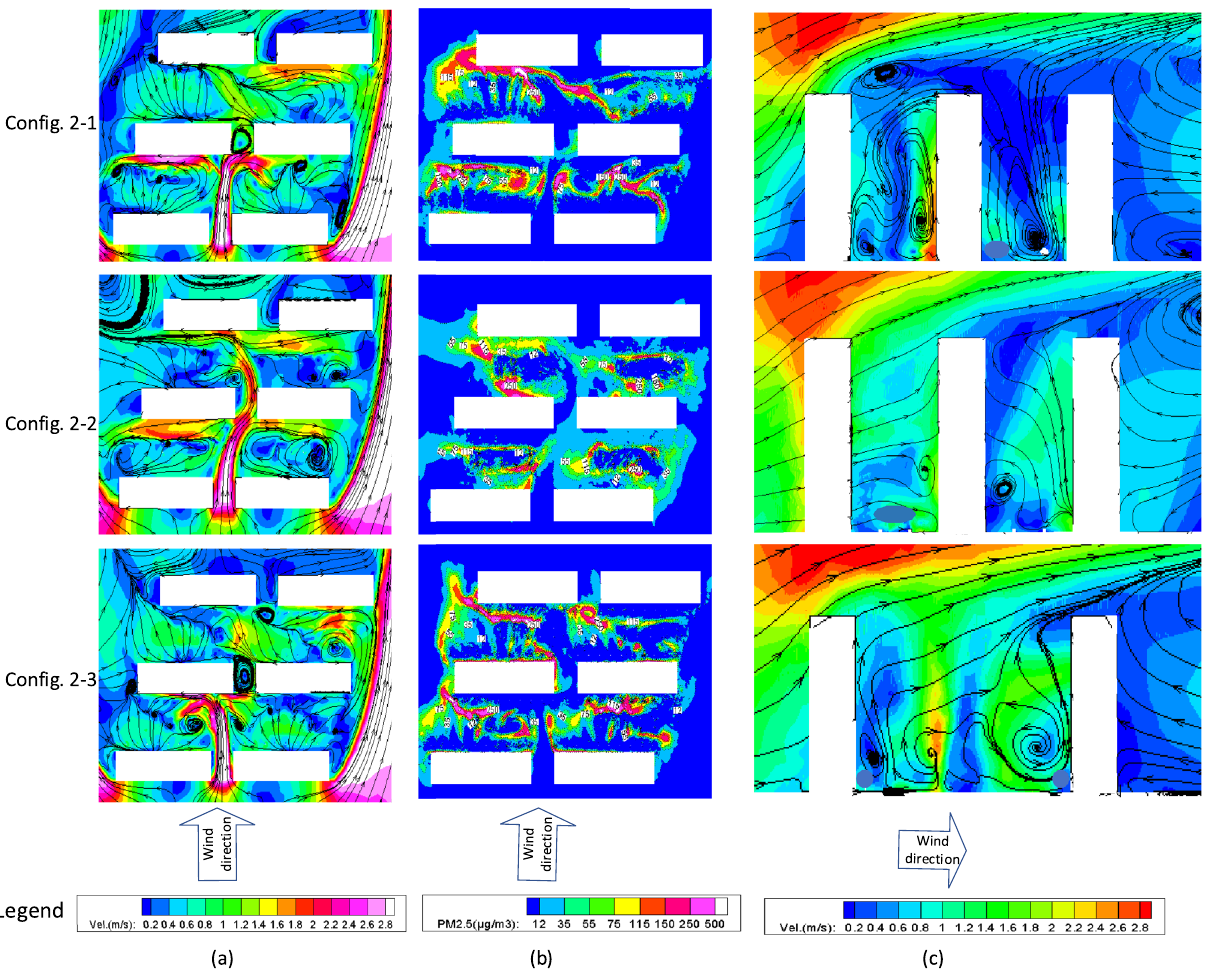
Figure 6. Plan view of the ( a ) wind velocity; ( b ) PM 2.5 concentration at pedestrian height, and ( c ) lateral view of the wind velocity for